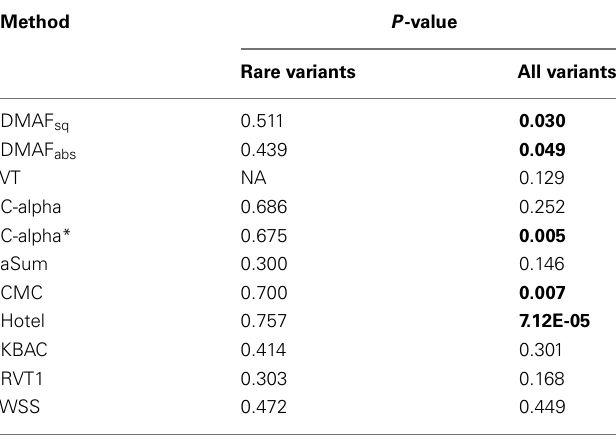
Table 7 | P -values for association between gemcitabine sensitivity and genotypes at 641 loci in FKBP5